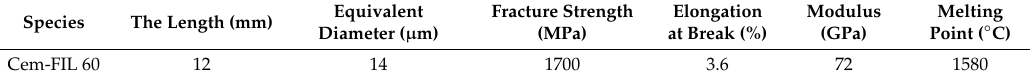
Table 1. Type and parameters of ARGF.